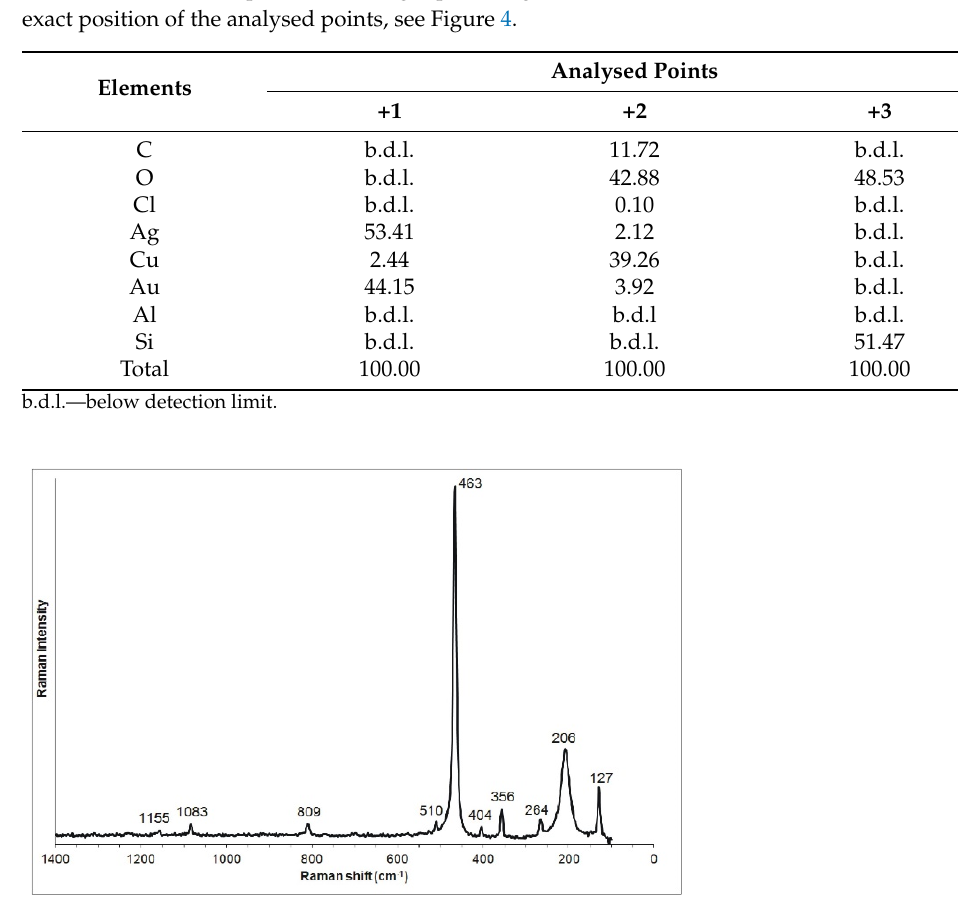
Figure 5. Representative characteristic Raman spectrum of the cross material.